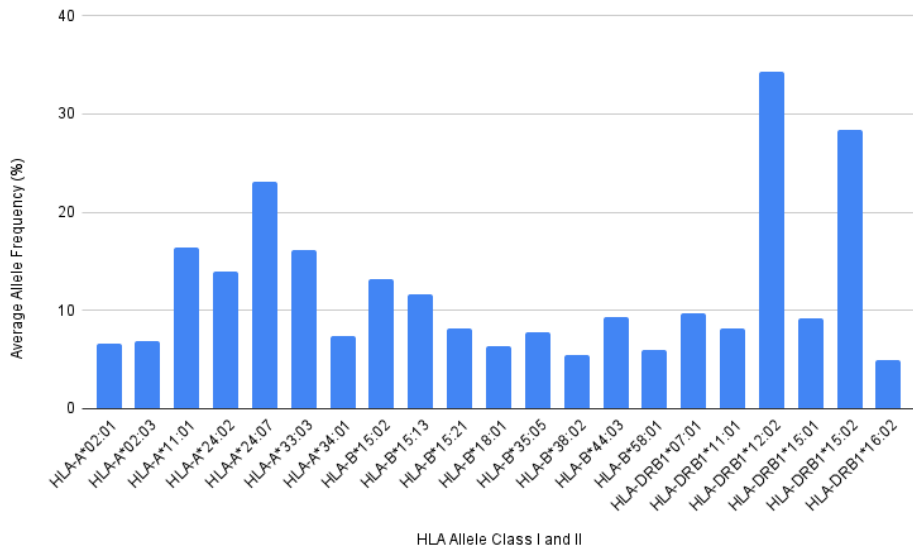
Figure 1. HLA Allele of Indonesian population with frequency equal or more than 5% identified from Allele Frequency Net Database. A total of 21 alleles were identified: 6 HLA Class I A, 8 HLA Class I B, and 6 HLA Class II DRB1